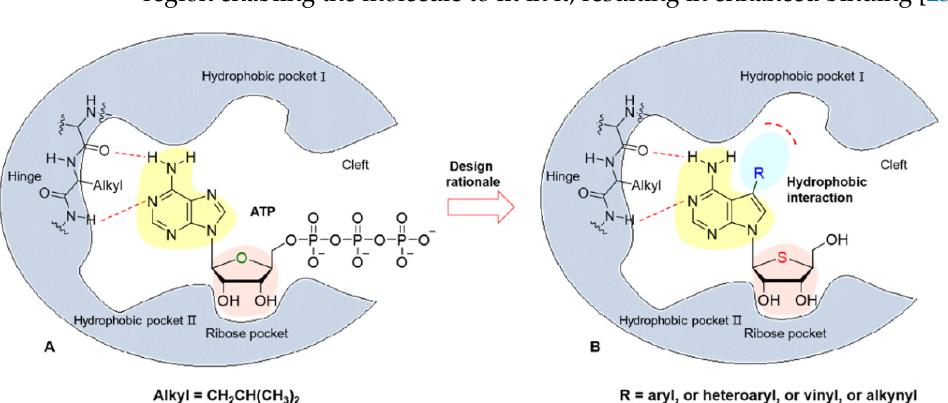
Figure 1. The rationale for the design of multi-kinase inhibitors with a nucleoside skeleton. ( A ) Schematic representation displaying catalytic domain of typical protein kinases binding ATP. Important interactions are highlighted with either colored or dashed lines, indicating hydrophobic interaction/hydrogen bonding. ( B ) Rational design of kinase inhibitors based on ATP-kinase interactions.